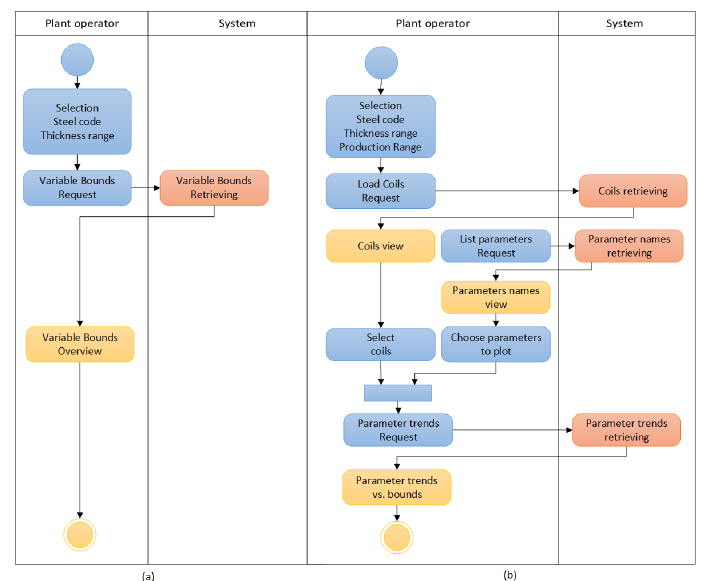
Figure 9. UML activity diagrams for plant operator use cases: ( a ) process parameter bounds visualization; ( b ) and process parameter trends visualization. When started, such module shows a window where the user can select a steel code and a thickness range as well as the functionality to be executed (see Figure 10). By clicking on the “Lower/Upper Bounds” button, the suggested process parameters and their associated bounds can be visualized in a second window. Such window also allows visualizing all the available process parameters and, in this case, the suggested ones are marked as selected and highlighted with dark blue color, such as exemplarily depicted in Figure 10.